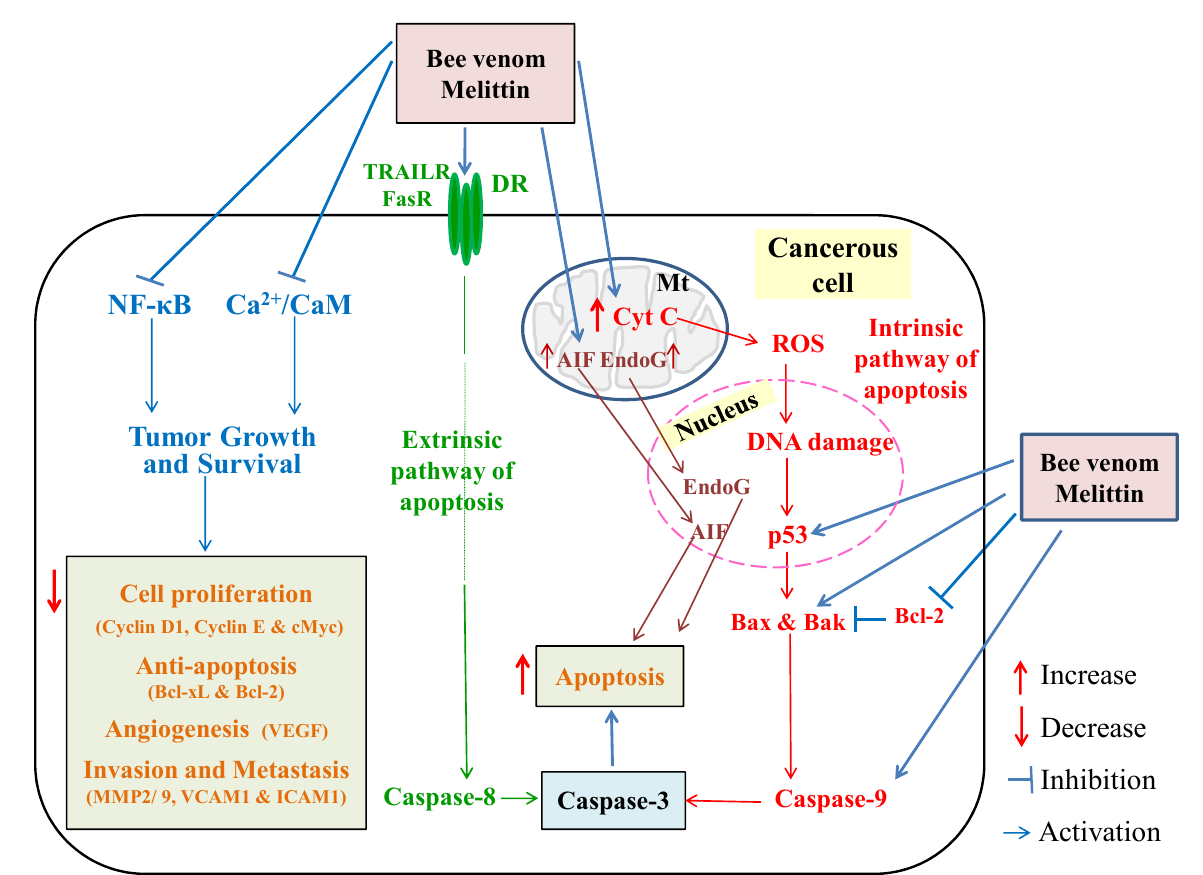
Figure 3. Schematic figure showing the proposed anti-cancer mechanisms of action of bee venom and melittin. DR, death receptor; Cyt C, cytochrome C; ROS, reactive oxygen species; DNA, deoxynucleic acid; p53, protein 53; Bcl-2, B-cell lymphoma 2; Bax, Bcl-2-associated Xprotein; Bak, Bcl-2 homologues antagonist/killer; NF- κ B, nuclear factor- κ B; Ca 2+ /CaM, calcium-calmodulin complex; VEGF, vascular endothelial growth factor; VCAM1 vascular cell adhesion molecule 1; ICAM1, inter-cellular adhesion molecule 1; MMP2/9, matrix metaloproteinase 2 and 9; cMyc, c- Myelocytomatosis; Bcl-xL, B-cell lymphoma extra-large; AIF, apoptosis-induced factor; EndoG, endonuclease G; TRAILR, TNF-related apoptosis-inducing ligand receptor ; FasR , fasreceptor.